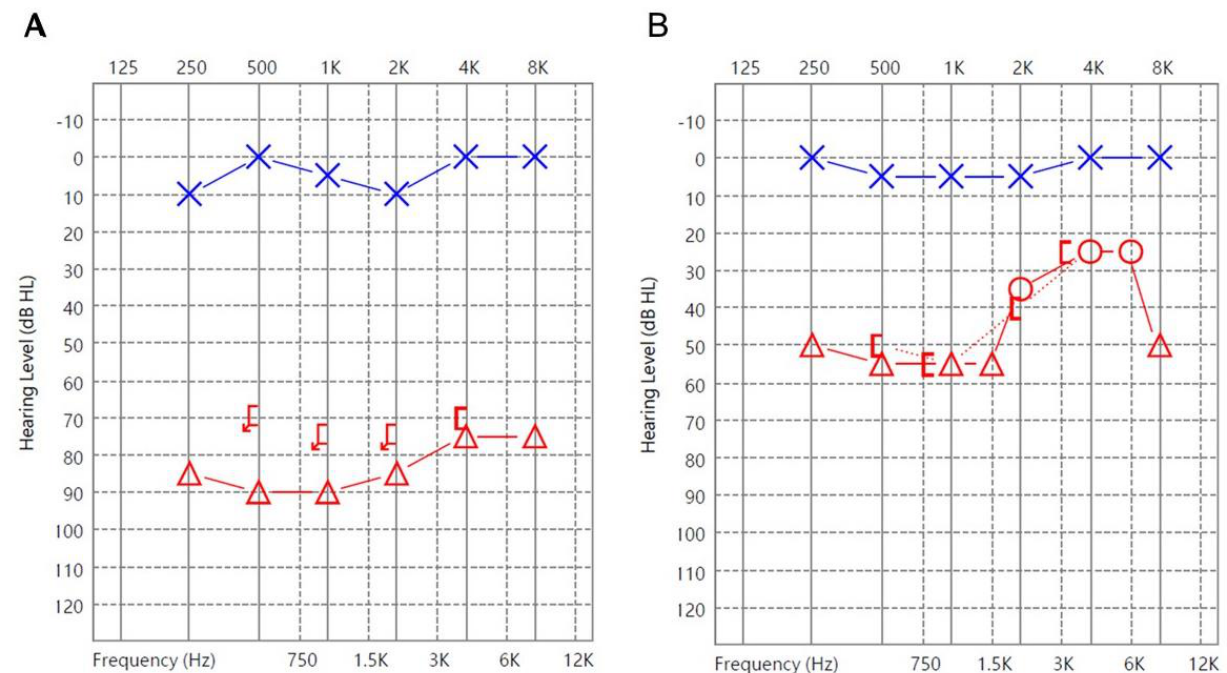
Figure 2. Audiograms of Patient 2 with positive PCR: ( A ) at presentation and ( B ) 2 months after treatment. (O: Unmasked air conduction thresholds in the right ear; X: Unmasked air conduction in the left ear; [: Masked bone conduction in the right ear; Δ : Masked air conduction in the right ear; Arrows (on any symbol): No response).